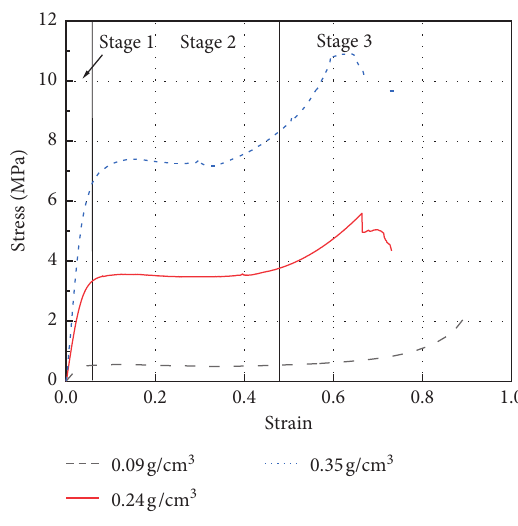
Figure 7: Stress-strain Table 2: Mechanical parameters of specimens with different densities.